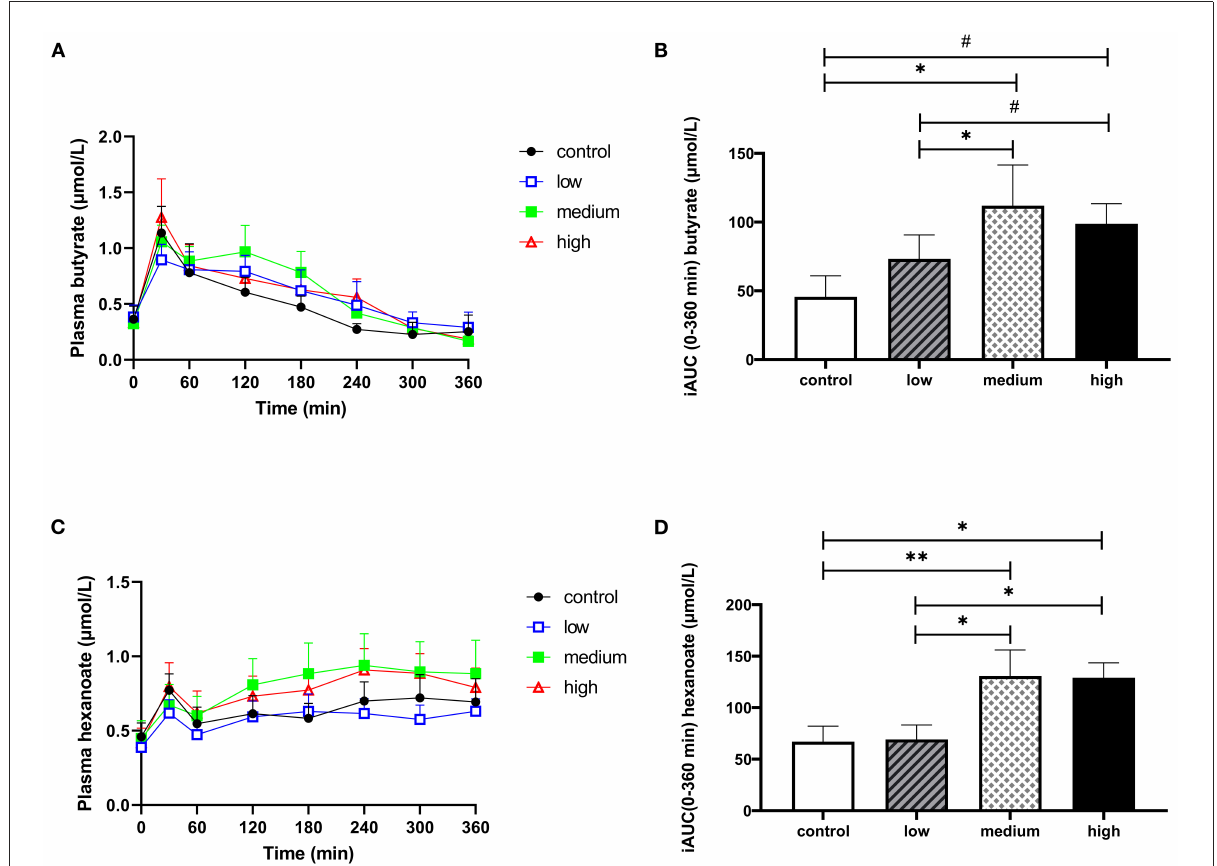
FIGURE3 The effect of butyrate and hexanoate-enriched triglycerides on the circulating short chain fatty acids. (A, B) Butyrate and (C, D) hexanoate. (A) Postprandial plasma butyrate concentrations (t0–t360min) after butyrate and hexanoate-enriched triglyceride ingestion. (B) iAUC for postprandial (t0–360min) plasma butyrate following butyrate and hexanoate-enriched triglyceride ingestion. Overall treatment effect (Type III Test of Fixed Effects) for postprandial plasma butyrate p = 0.032. (C) Postprandial plasma hexanoate concentrations (t0–t360min) after butyrate and hexanoate-enriched triglyceride ingestion. (D) iAUC for postprandial (t0–360min) plasma hexanoate following butyrate and hexanoate-enriched triglyceride ingestion. Overall treatment effect (Type III Test of Fixed Effects) for postprandial plasma hexanoate p = 0.007. Values are presented as means ± SEMs ( n = 12). Differences in postprandial iAUC between the four doses interventions (control, low, medium, high) were analyzed by a linear mixed model for repeated measures and the indicated p -values represent post-hoc testing. Statistical significance indicated with an asterisk (*) if p < 0.05, (**) if p < 0.01 and (#) if p < 0.10, indicating a trend. iAUC, incremental area under the curve.